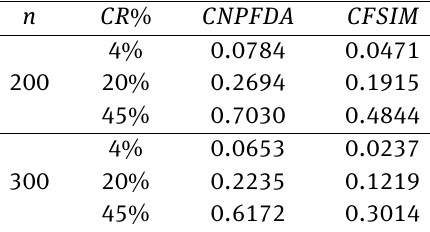
Table 1: MSE comparaison for CFSIM and CNPFDA